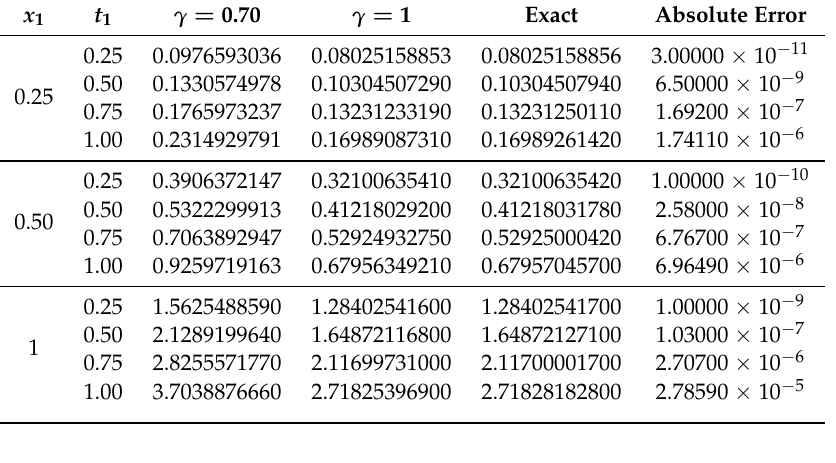
Table 2. Numerical results of Example 2 at γ = 0.70 and γ = 1.